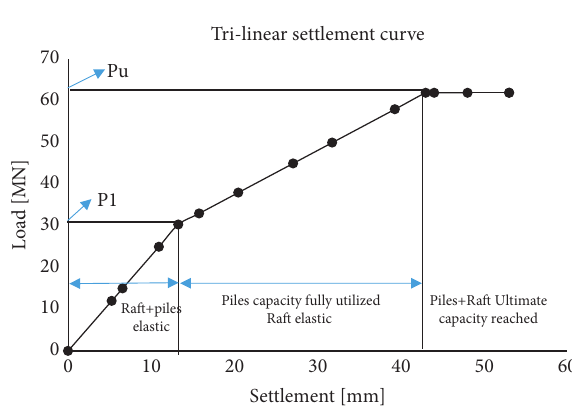
Figure 3: Trilinear settlement curve for case study 1.